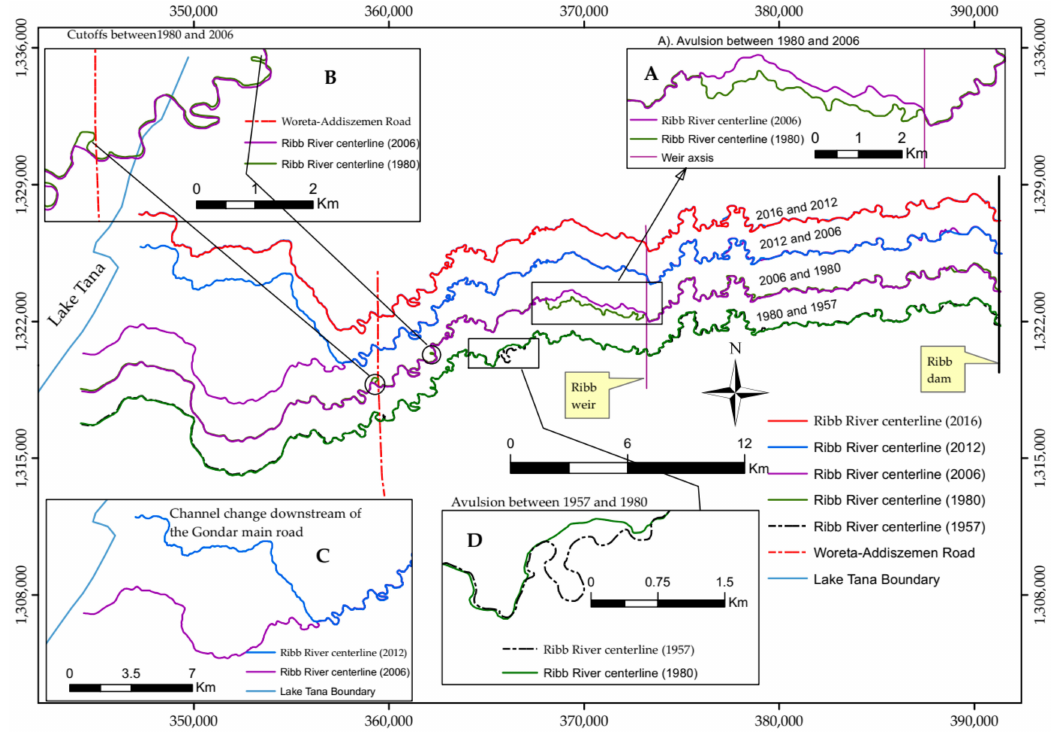
Figure 14. Successive Ribb River centerlines. ( A ) avulsion developed between the years 1980 and 2006; ( B ) cut-off developed between the years 1980 and 2006; ( C ) complete channel change between the years 2006 and 2012; ( D ) cut-off developed between the years 1957 and